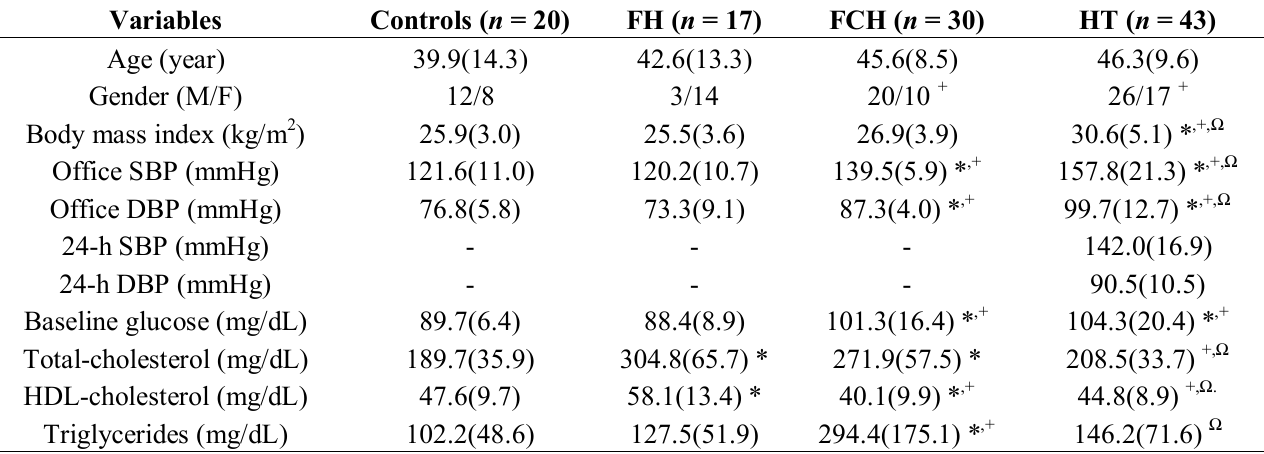
Table 1. General characteristics of the study